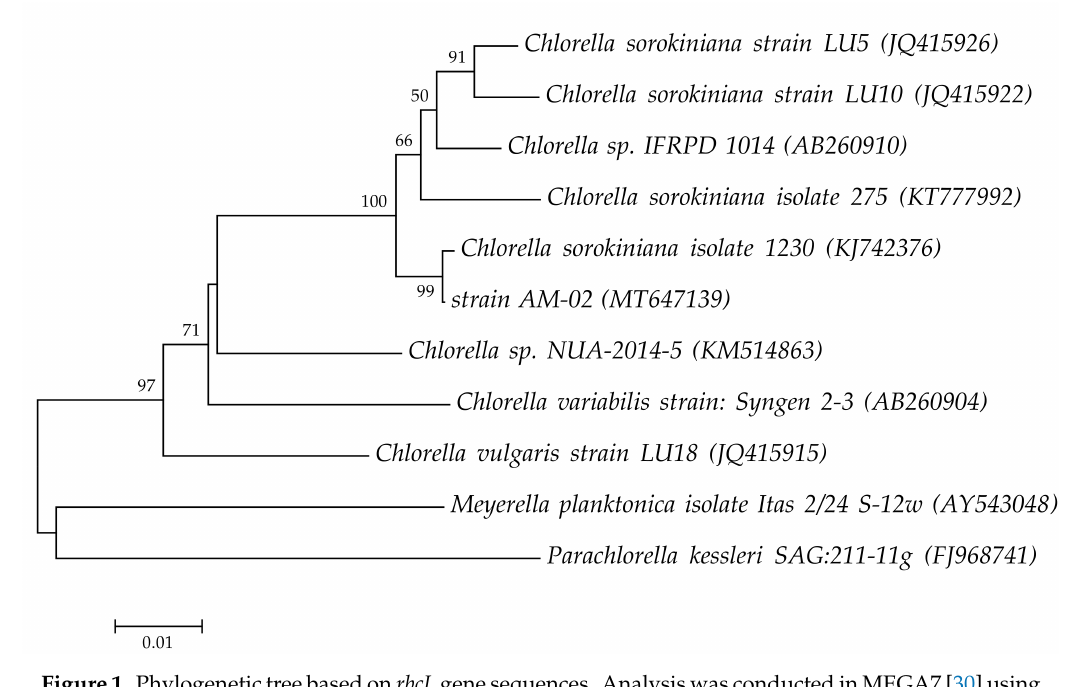
Figure 1. Phylogenetic tree based on rbcL gene sequences. Analysis was conducted in MEGA7 [30] using the neighbor-joining method. The percentages of replicate trees in which the associated taxa clustered together in the bootstrap test (1000 replicates) are shown next to the branches. The evolutionary distances were computed using the Kimura 2-parameter method. Meyerella planktonica and Parachlorella kessleri were used as